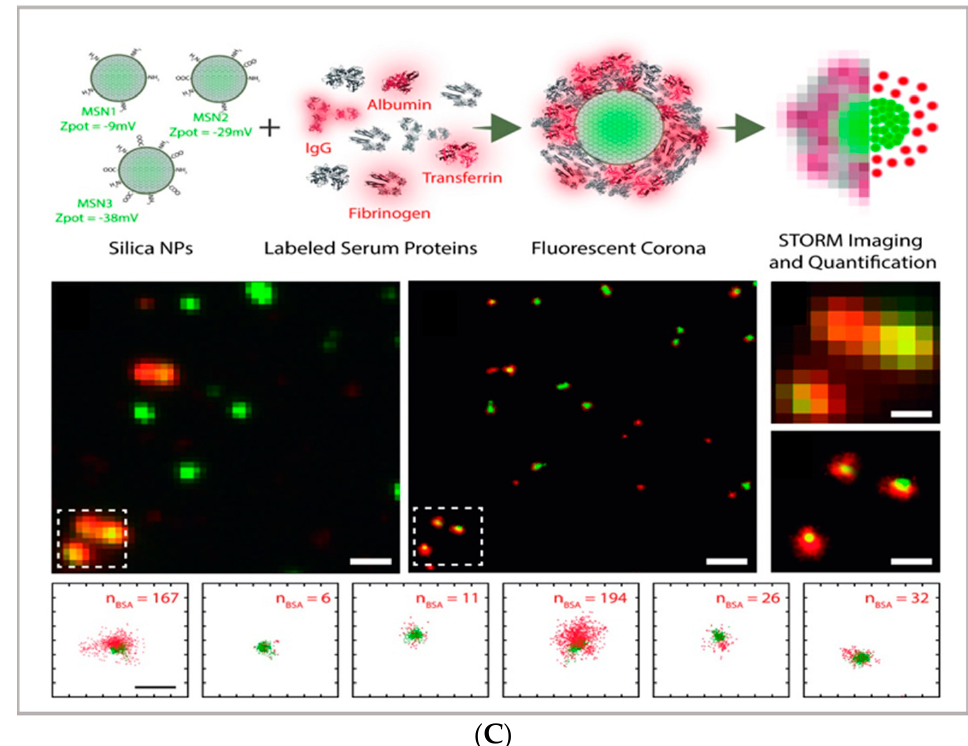
Figure 1. ( A ) comparison between the image acquisition/reconstruction modes of different techniques. Laser scanning confocal microscopy (LSCM) is based on a diffraction-limited point acquisition, which is scanned across the specimen through the scan-head to reconstruct the full image. Stimulated emission depletion microscopy (STED) acquisition relies on the combination of two diffraction-limited laser beams (an excitation beam and a donut-shaped depletion beam), whose combination produces a virtually unlimited decrease in the size of the point spread function; the image acquisition/reconstruction is obtained, similarly to LSCM, through a non-diffraction limited point acquisition, which is scanned across the specimen through the scan-head, to reconstruct the full image. STORM/PALM techniques rely on the employment of low concentrations of photo-switchable probes excited at a low intensity; the stochastic activation of single fluorophores allows for the determination of their precise localization, whereas repeated on-off cycles allow for the random activation of all the fluorophores in the specimen, and the combination of the cycles allows for the reconstruction of the high-resolution image [32]. ( B ) examples of high-resolution STORM and STED images compared to lower resolution LSCM images acquired for the same sample: ( a – c ) STORM images of BS-C-1 cells (( a , b ) mitochondrial proteins Tom20 (green) and ATP Synthase (red), and ( c ) mitochondria protein Tom20 (red) and microtubules (green)); ( d – f ) multi-color STED images of PtK2 cells. All images are 10 × 10 µm in size (adapted with permission from [31] copyright (2015) WILEY-VCH Verlag GmbH & Co. KGaA, Weinheim, Germany). ( C ) examples of super-resolution techniques applied to drug delivery research (adapted with permission from [33]. Scale bar 200 nm; copyright (2017) WILEY-VCH Verlag GmbH & Co. KGaA, Weinheim,